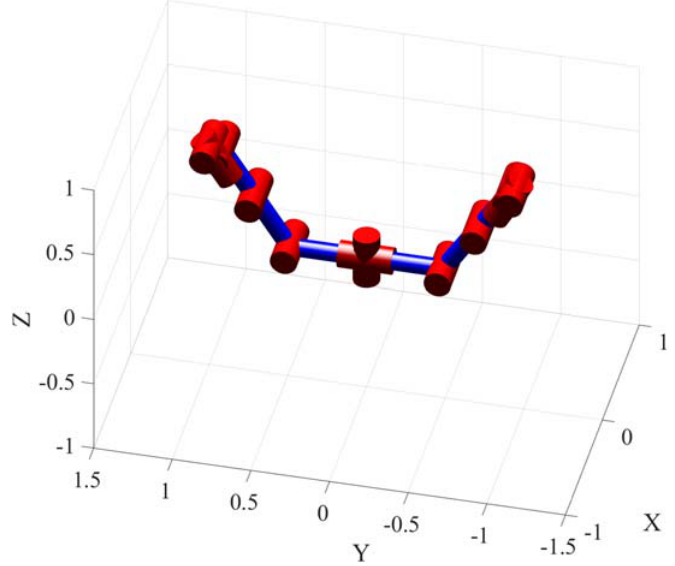
Figure 1. The model of the dual-arm robot.